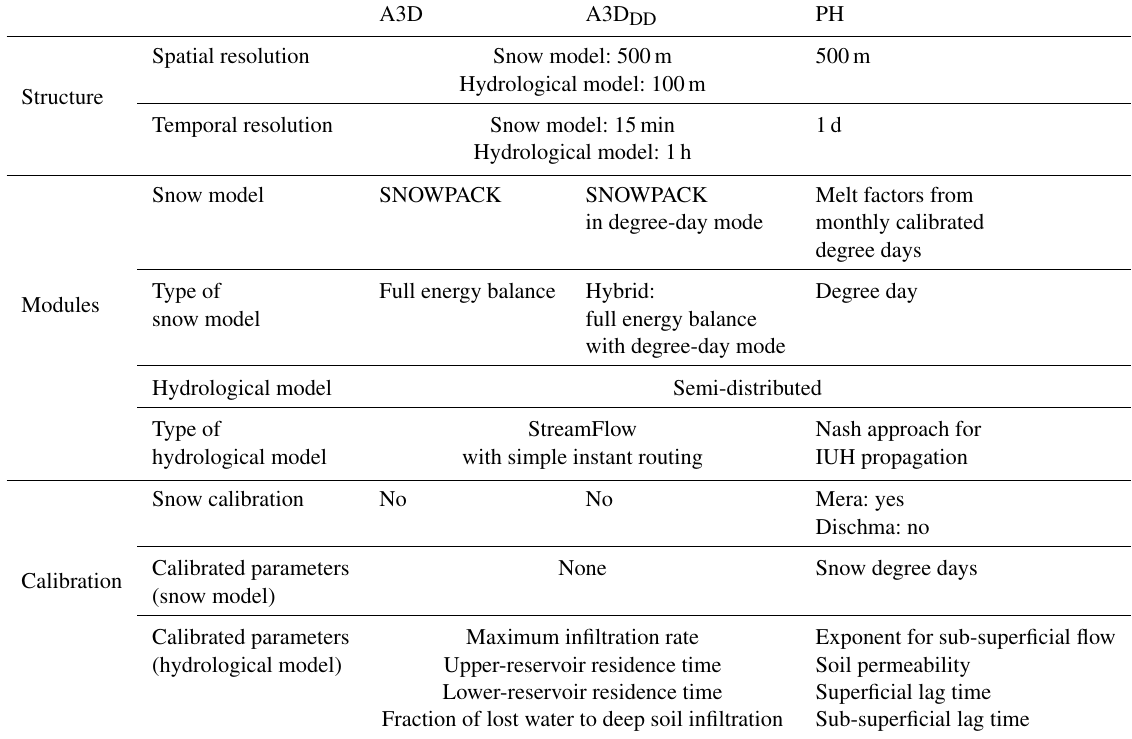
Table 5. Summary of the main features and differences of the models used for the case